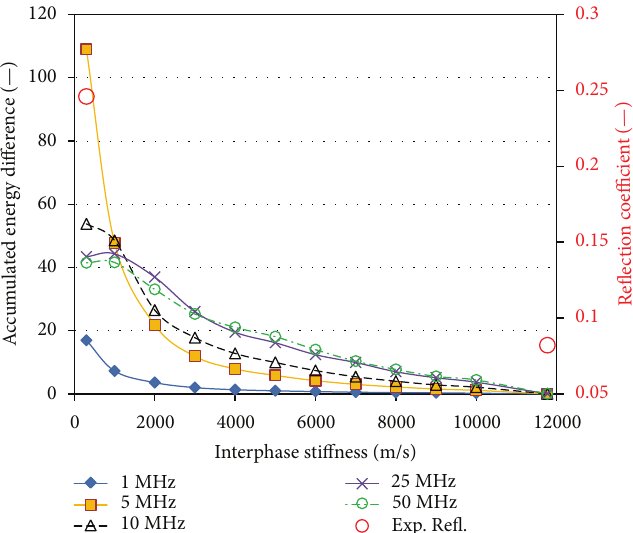
Figure 8: Reflection energy difference for several values of interphase stiffness (longitudinal velocities) and different